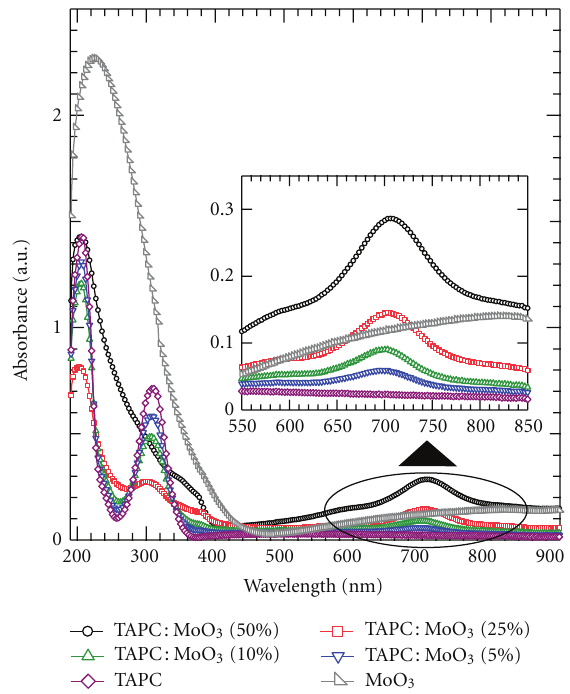
Figure 1: Optical absorption spectra of MoO 3 , undoped TAPC, and MoO 3 -doped TAPC films with di ff erent MoO 3 concentrations. Inset: increase of CT complex absorption peak (703nm) as the MoO 3 concentration